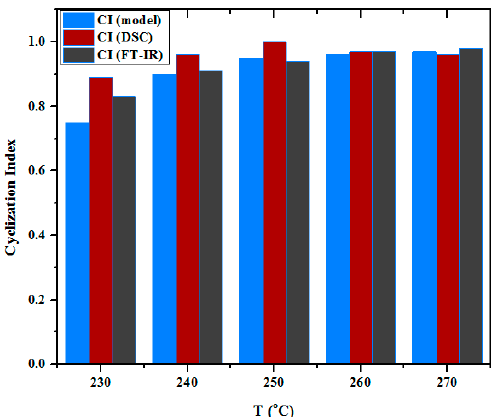
Figure 13. Comparison of estimations for the cyclization progress derived from three different methods: Chemical shrinkage model, DSC, and FTIR.